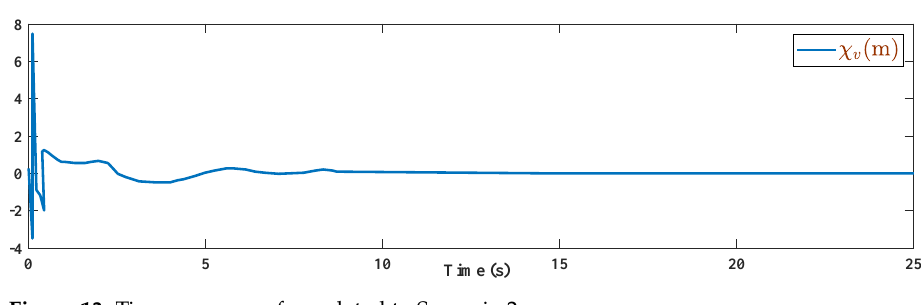
Figure 13. Time response of x v related to Scenario 2.